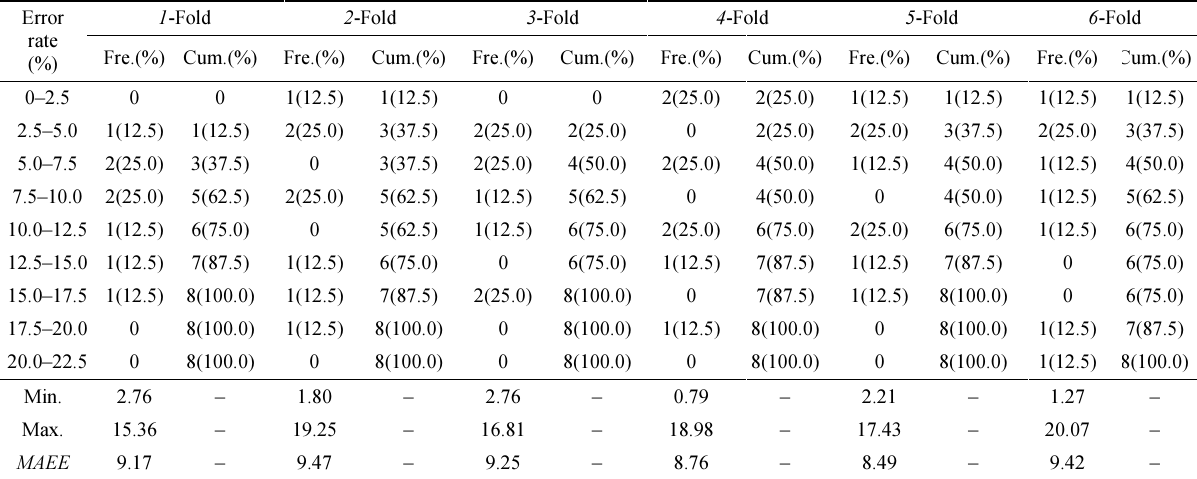
Table 6. Cost reasoning errors for 6-fold cross-validation of the AHP-CBR system 1 -Fold 2 -Fold 3 -Fold 4 -Fold Error rate Fre.(%) Cum.(%) (%) 2.5–5.0